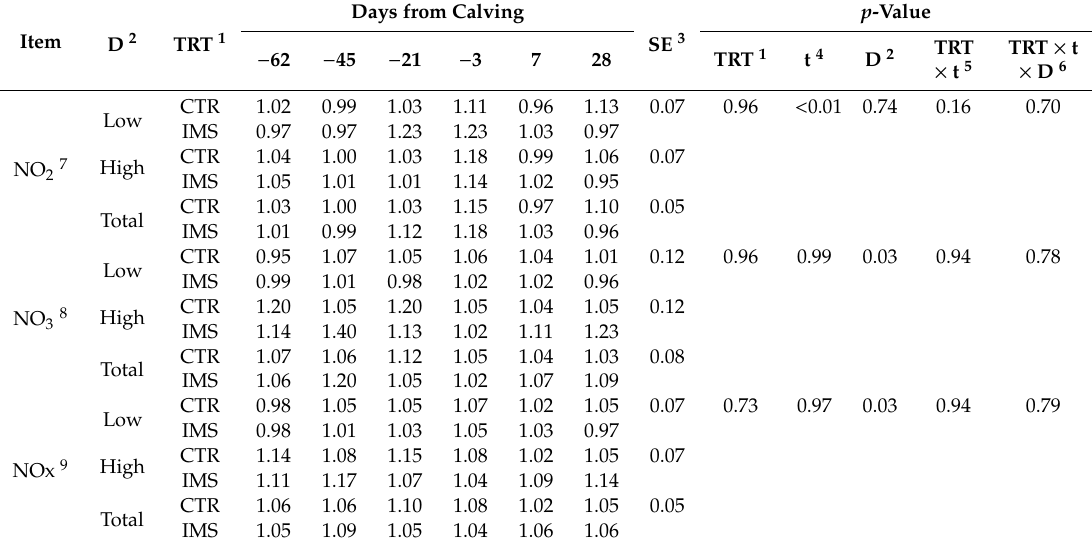
Table 7. Fold change values (expressed with respect to baseline) of nitrogen species after a whole blood stimulation assay with a low or high dose of bacterial lipopolysaccharides in control dairy cows (n = 5) or cows receiving 65 g*d − 1 of Omnigen-AF ® as top-dress between − 55 and 42 days from calving (n =